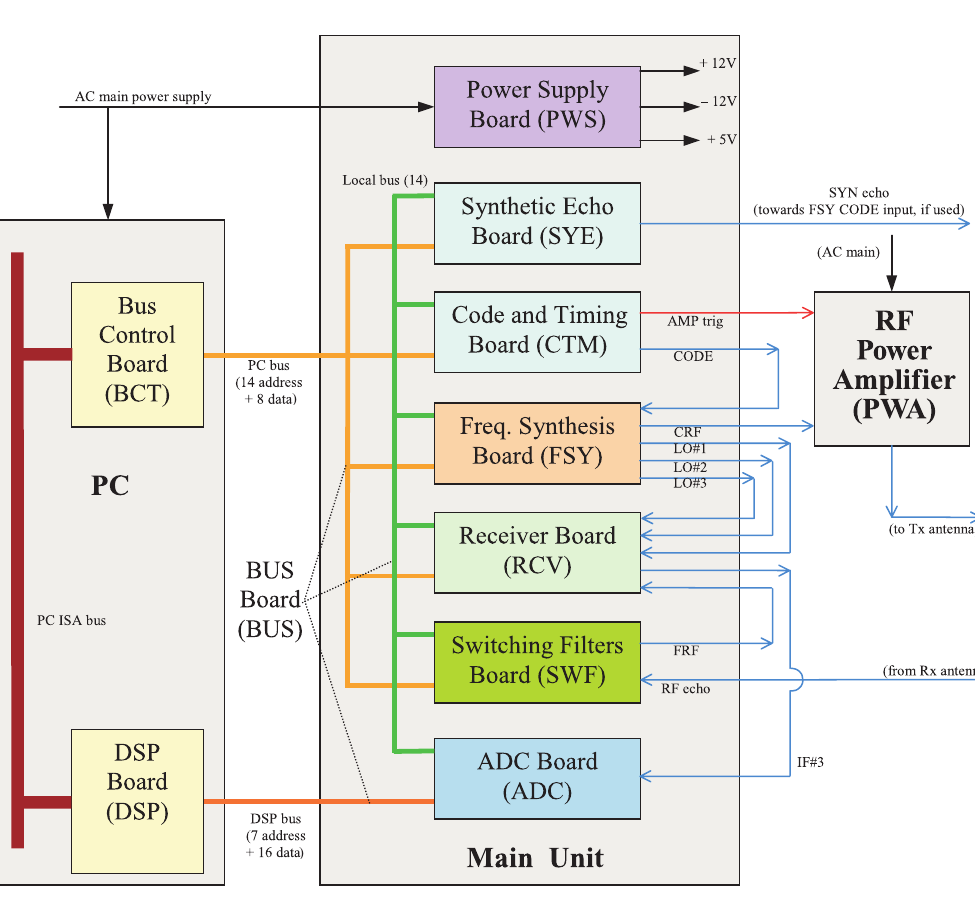
Fig. 2. The ionosonde subsystems. Interconnections (antennas not